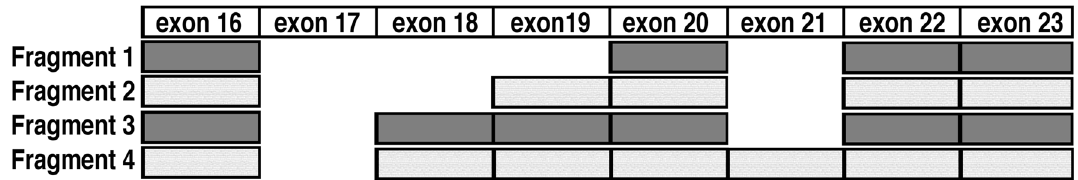
Figure 4. Sequencing of the periostin isoforms. Based on sequencing the exon usage of the four periostin isoforms isolated from the GI tissue in patients and healthy controls is shown. No alternative splicing occurs in exons 1–16 and the last exon 23 with the stop codon is also present in all variants. Fragment 1 contains exons 16, 20, 22 and 23 and is exactly 188 bp long, while fragment 2 contains additionally exon 19 and is 278 bp long. Fragment 3 additionally has exon 18 present and is 368 bp long and fragment 4 contains also exon 21 and is 452 bp long. Interestingly, we did not identify any trace of the full-length fragment that also retains exon 21 and would be expected to be 536 bp in